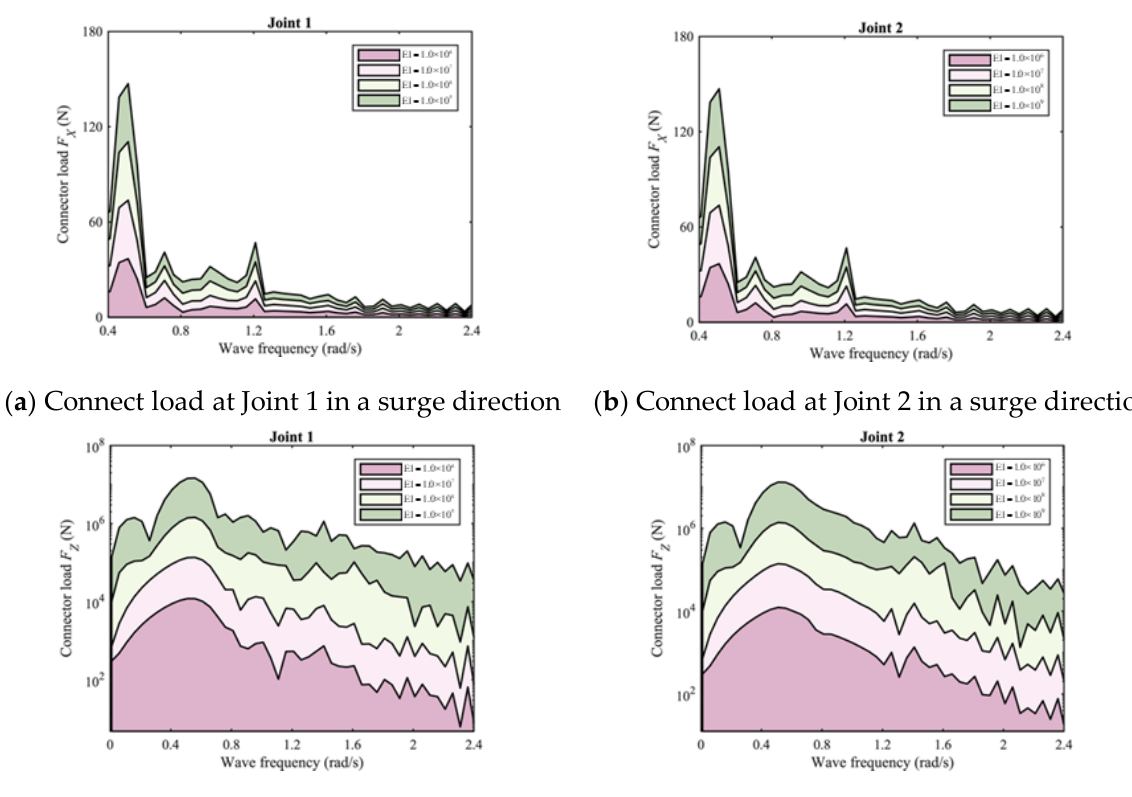
Figure 10. Connector loads on common joints between beam elements. Table 3. The peak value of the connector loads on common Table 2. The peak value of the constraint force acting on each module.